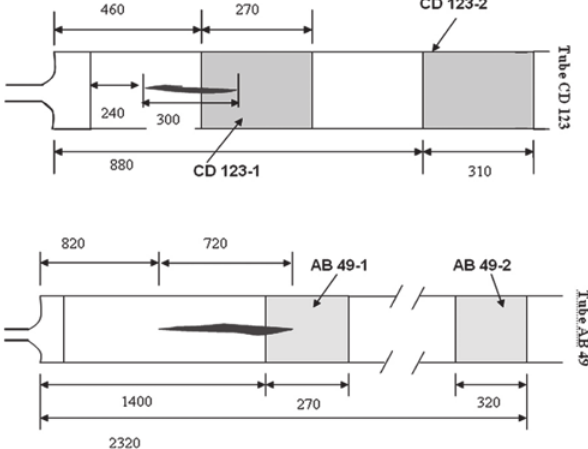
Fig. 9: Schematic of sampling cut for failure analysis and remaining life assessment (RLA). All dimensions are in mm [24].